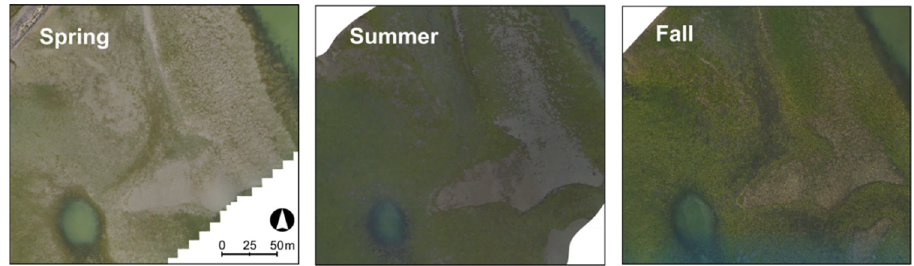
Figure 6. UAV imagery from March (‘Spring’), July (‘Summer’), and October (‘Fall’) 2019 at the focus site OM. At this site at the head of the bay, eelgrass cover increased over the course of the year.